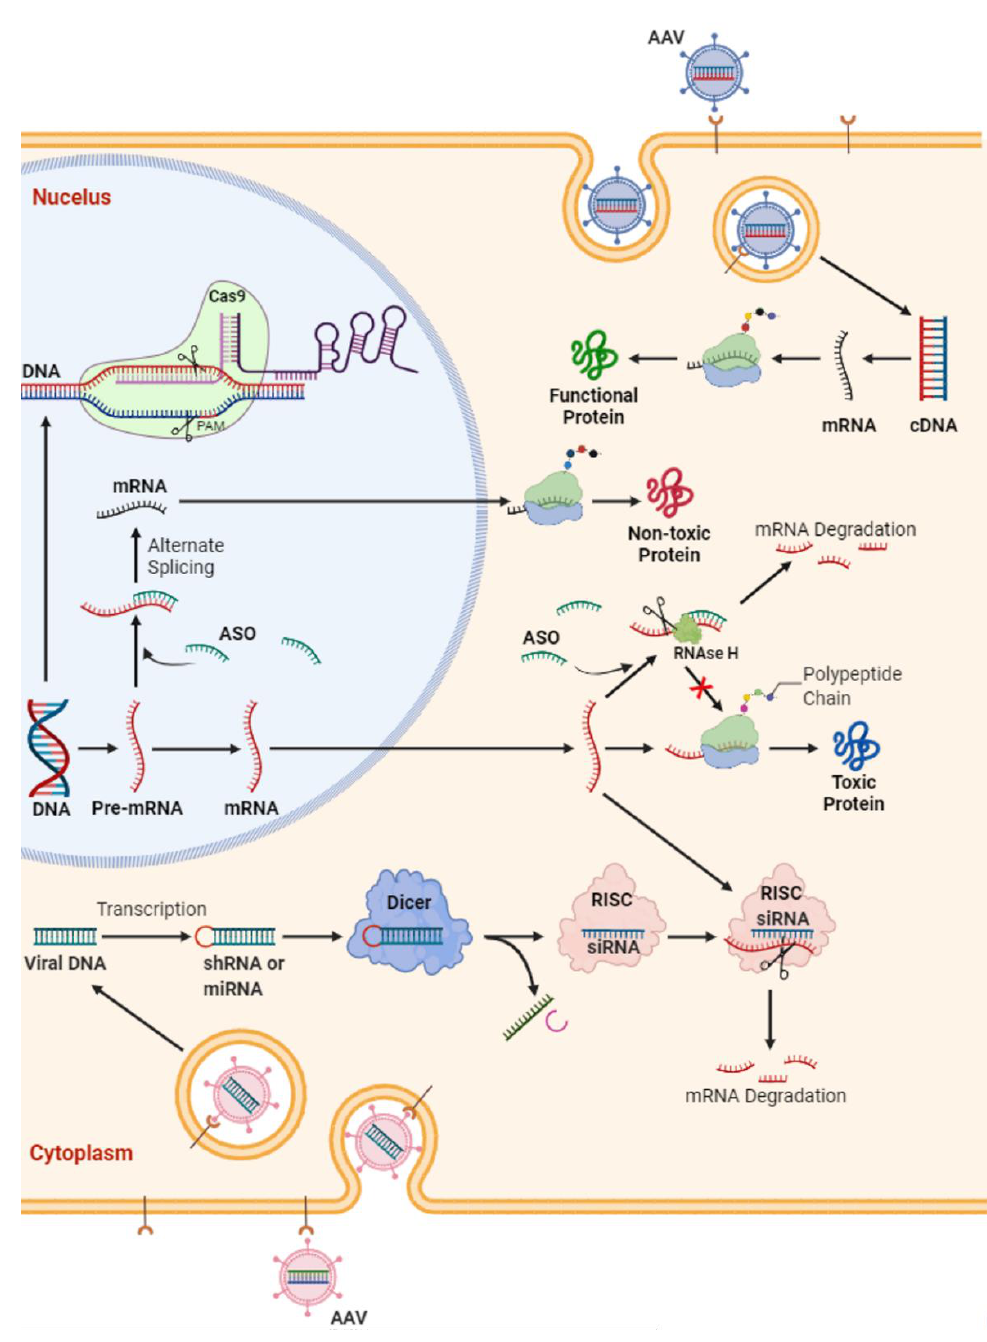
Figure 1. Schematic representation of potential strategies in gene therapy for amyotrophic lateral sclerosis. Antisense oligonucleotide (ASO) are short synthetic oligonucleotides (~20 nucleotides). They bind to the targeted mRNA and either (i) induce the mRNA degradation by endogenous RNase H or (ii) block the mRNA translation. This ultimately decreases the expression of certain proteins. In ALS, this strategy has been utilized to reduce the protein level of TDP-43, SOD1 of FUS protein level or to target C9orf72 RNA foci. SiRNAs are double-stranded RNAs that can bind argonaute proteins as part of the RNA-induced silencing complex (RISC), which ultimately leads to the mRNA cleavage. Gene (i.e., either mRNA or cDNA) delivery through viruses (e.g., adeno-associated viral vectors [AAV]) is another option for functional replacement of a missing gene. This approach was utilized in spinal muscular atrophy but needs more investigation in ALS.